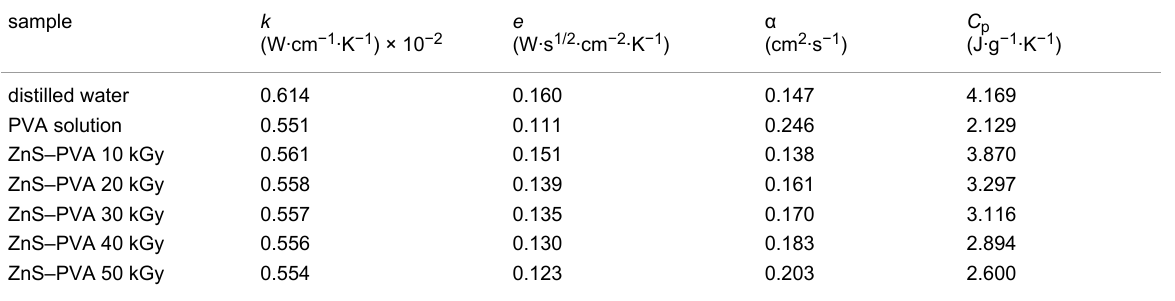
Table 2: Measured values of thermal conductivity ( k ) and thermal effusivity ( e ) in addition to the calculated values of thermal diffusivity ( α ) and specific heat ( C p ). sample